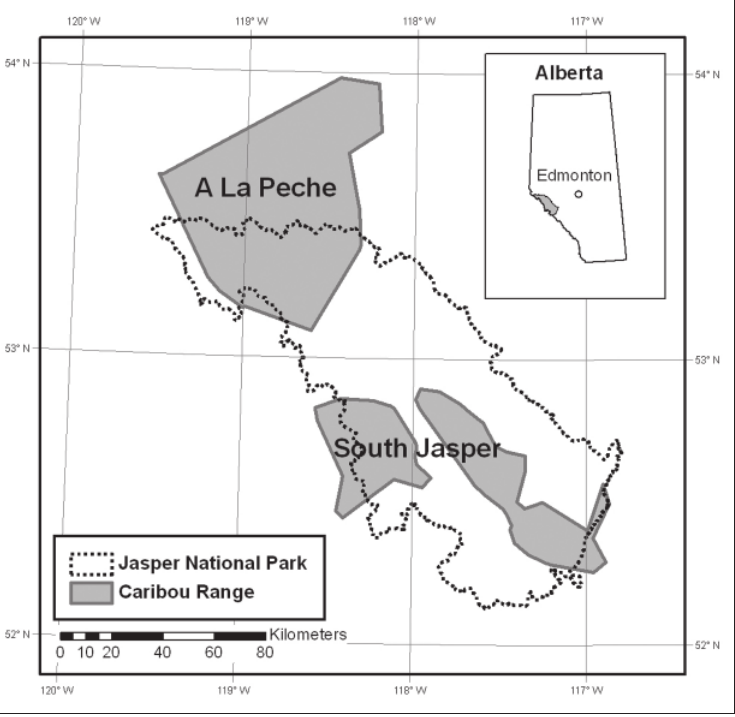
Fig. 1. Caribou ranges in Jasper National Park and surrounding areas.